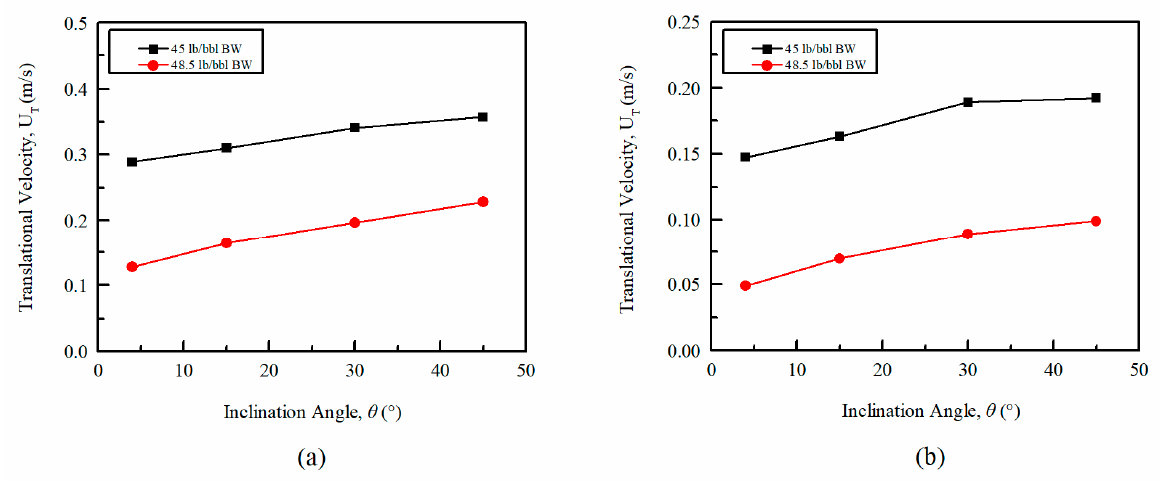
Figure 15. Influence of liquid viscosity on U T . ( a ) U L = 0.218 m/s; ( b ) U L = 0.5 m/s.